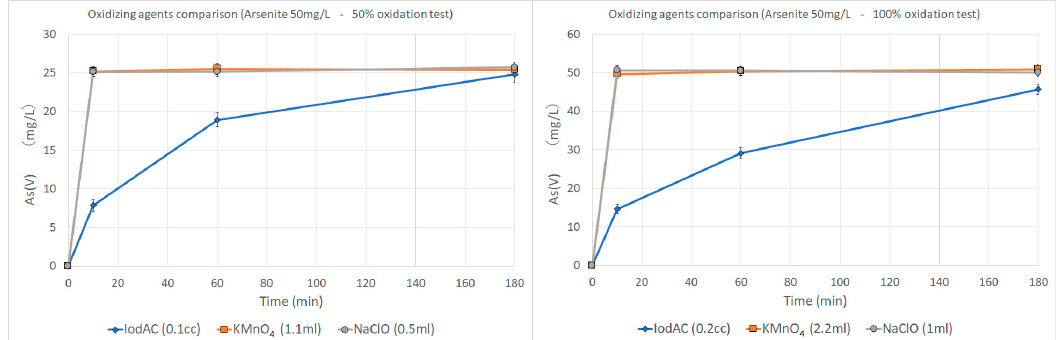
Figure 3. Comparison of the progress of oxidation by IodAC(30) and by the commonly used oxidizing agents.